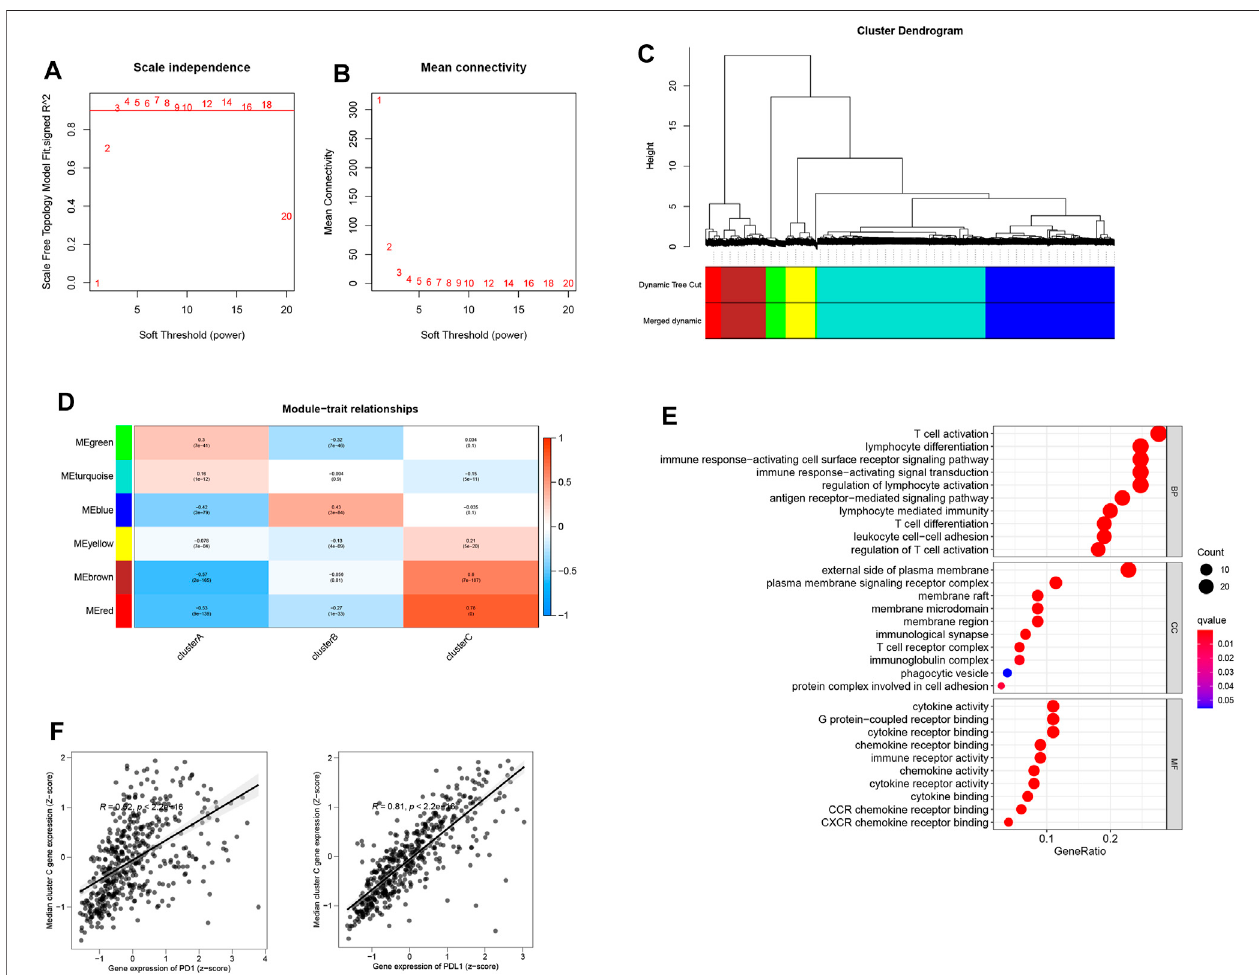
FIGURE4|(A) Scale-free fi tindexanalysisof1 – 20softthresholdpower β . (B) Meanconnectivityanalysisof1 – 20softthresholdpower. (C) Genesarehierarchically clustered into various modules indicated by different colors. (D) Heatmap displaying correlations among module eigengenes. (E) GO analysis of the red module genes. (F) Correlation of the median expression of genes (red module) with the PD-1/PD-L1